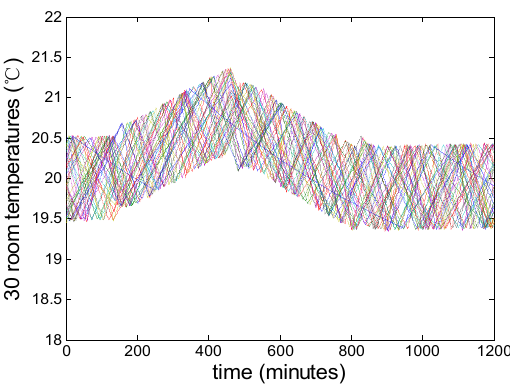
Figure 16. Variation of the indoor temperature of 30 random ACs in the population.